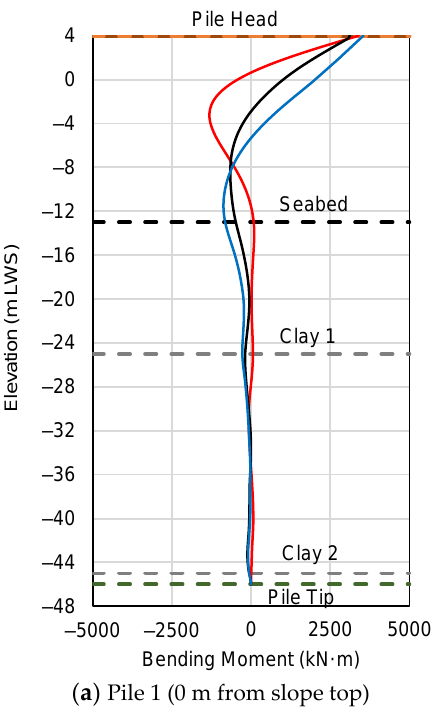
Bending Moment (kN·m)